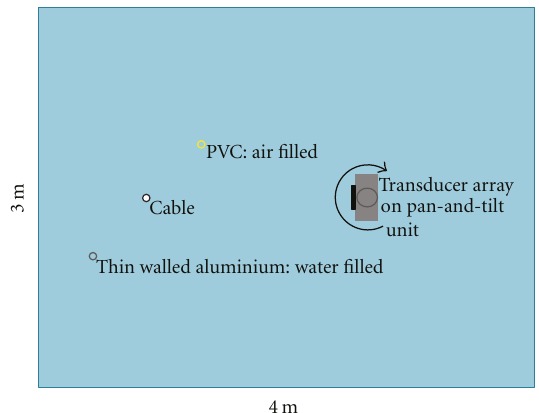
Figure 17: Test tank setup (plan view) with multiple narrow cylindrical targets. Transducer array is panned across the targets to get responses over the whole